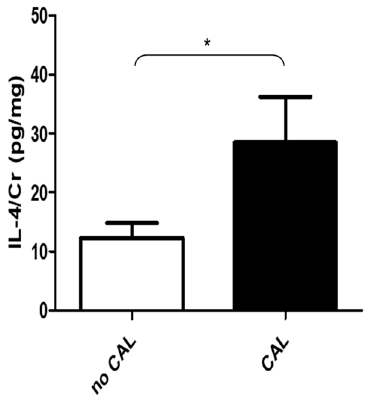
Figure 3. Urinary IL-4/urinary creatinine from KD patients with or without coronary artery lesion (CAL), tested by Mann–Whitney U test. * for p < 0.05.